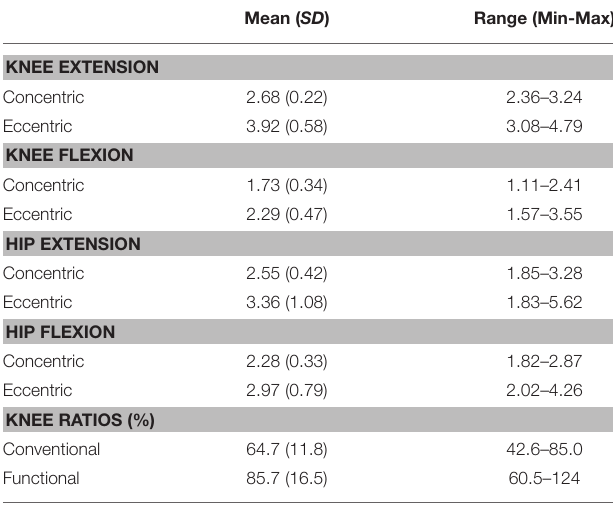
TABLE 1 | Data of hip and knee extension and flexion peak torques measured during isokinetic testing in concentric and eccentric